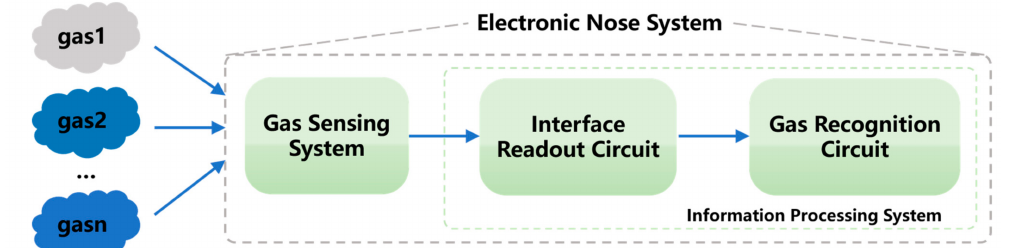
Figure 1. E-nose system